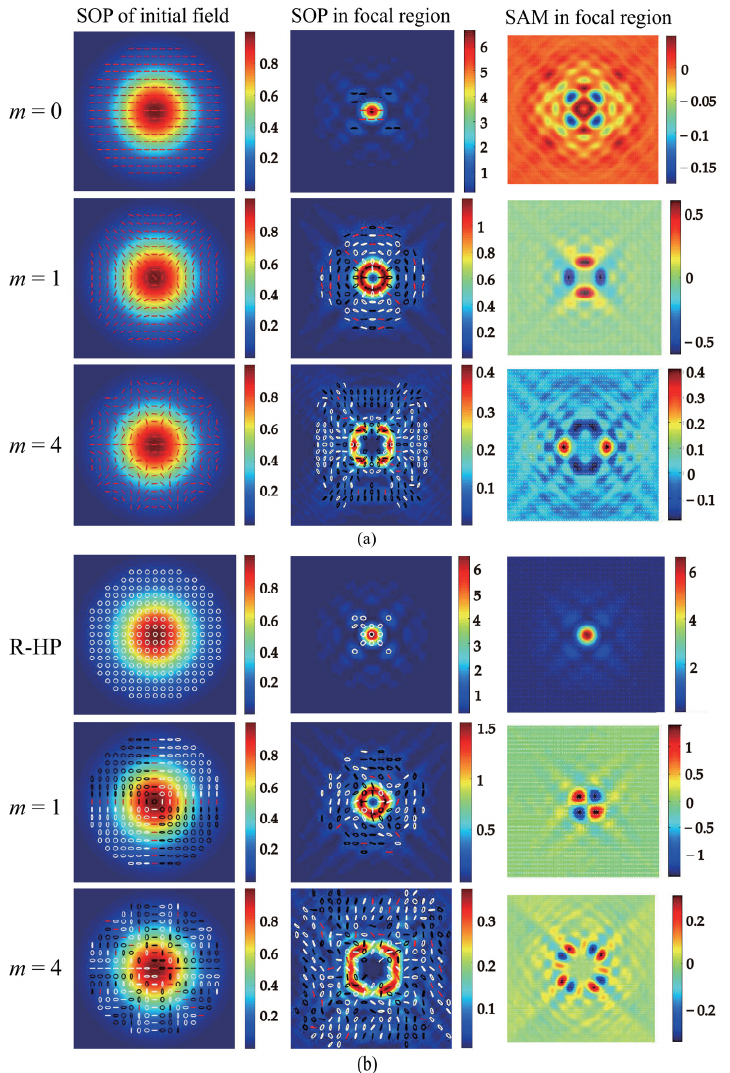
Figure 4. The SOP of scalar and vector beams in the initial field and focal region, and the corre- sponding SAM distribution in the focal region. The first column is the initial SOP of the input optical field, and the second and third columns are the SOP and SAM distributions with a twisting phase ( u = 10 13 mm − 2 ) in the focal region: ( a ) the locally linear polarization ( ∆ φ = 0 in Equation (1)), ( b ) the hybrid SOP ( ∆ φ = π /2 in Equation (1)). The size of each plot in the first column is 5500 λ × 5500 λ , and the size of each plot in the second and third columns is 3 λ × 3 λ . Here the vortex topological charge n = 0. The red, black, and white lines indicate the linear, left-, and right-polarizations,